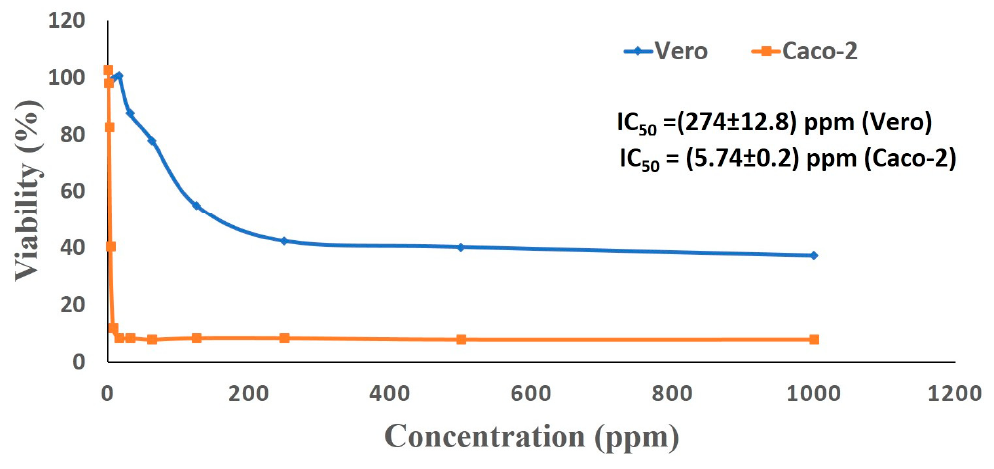
Figure 6. Cytotoxic activity of Ag-NPs derived from S. antimycoticus L-1 against Vero and Caco-2 cell lines.